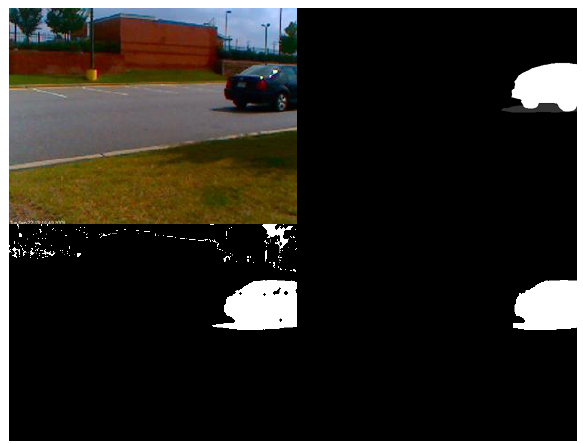
Table 6. Relative comparison of Modified algorithm to Original algorithm for all videos